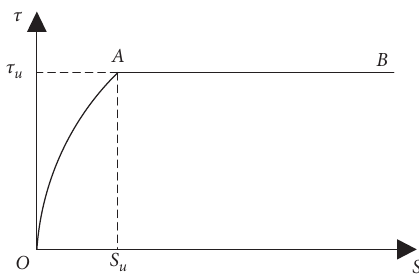
Figure 23: Simplified model for the τ − s curve of specimens with shear connectors.